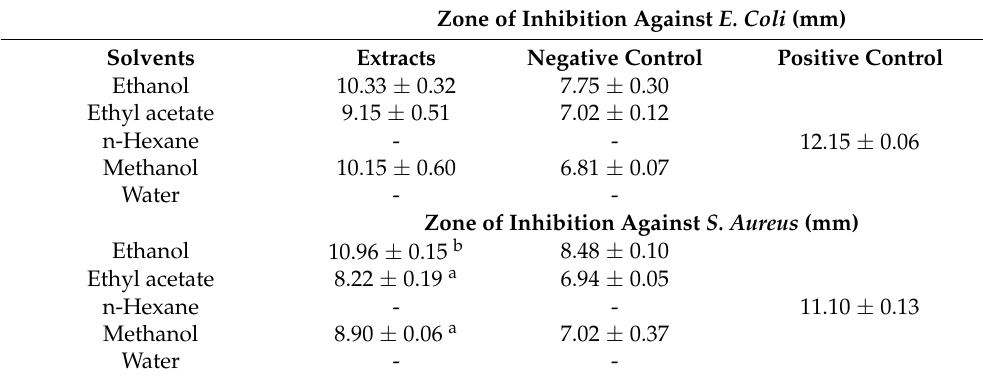
Table 5. Antibacterial effect of various leaf extracts of A. hendersonii against E. coli and S. aureus